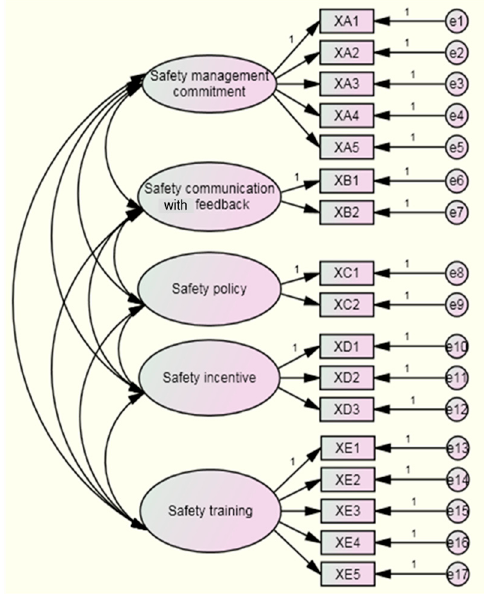
Figure 1. The single-factor structural model.